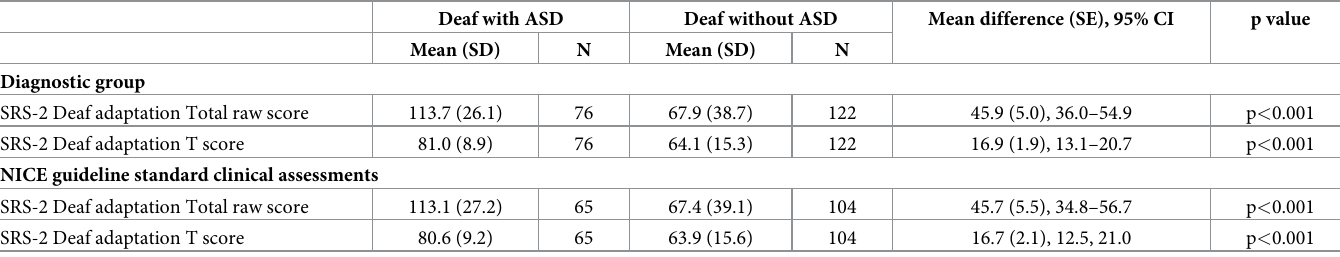
Table 4. Summary scores for SRS-2 Deaf adaptation by diagnostic group and NICE guideline standard clinical assessments only. Deaf with ASD Deaf without ASD Mean difference (SE), 95% CI p value Mean (SD) N Mean (SD)